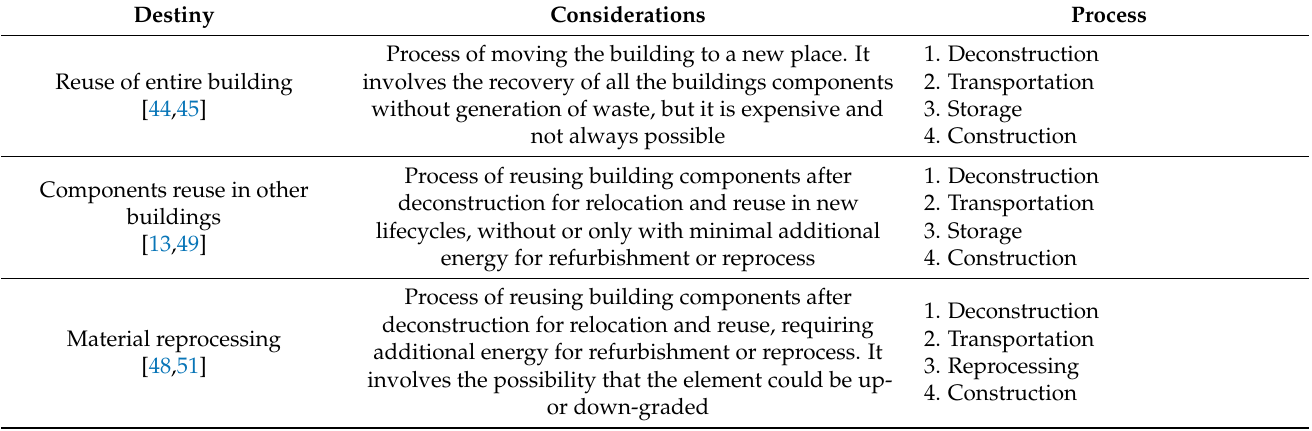
Table 2. Building’s deconstruction